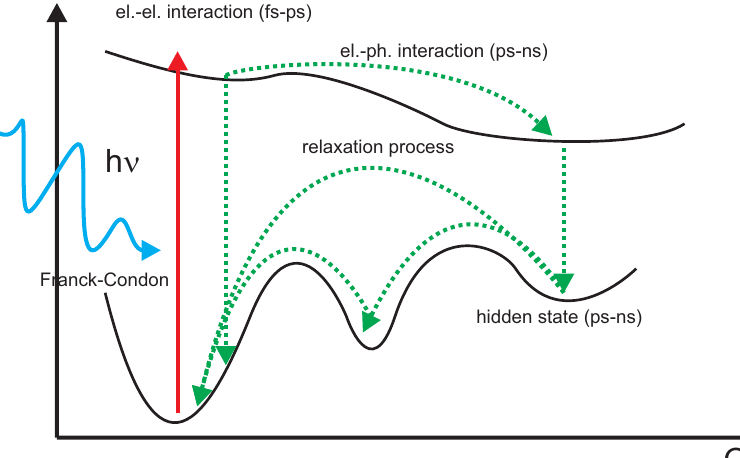
Figure 22. Sketch of the generation of a hidden metastable state by photons with a certain energy. The potential energy surface is shown for the ground and excited states (black solid lines) for a certain order parameter Q . The blue arrow symbolizes a photon with the energy h ν exciting vertically the ground state into a higher energy level. Different relaxation channels (green dotted lines) are possible which can result in a metastable hidden state with a different value of the order parameter from the ground state. It is separated from the initial state by energy